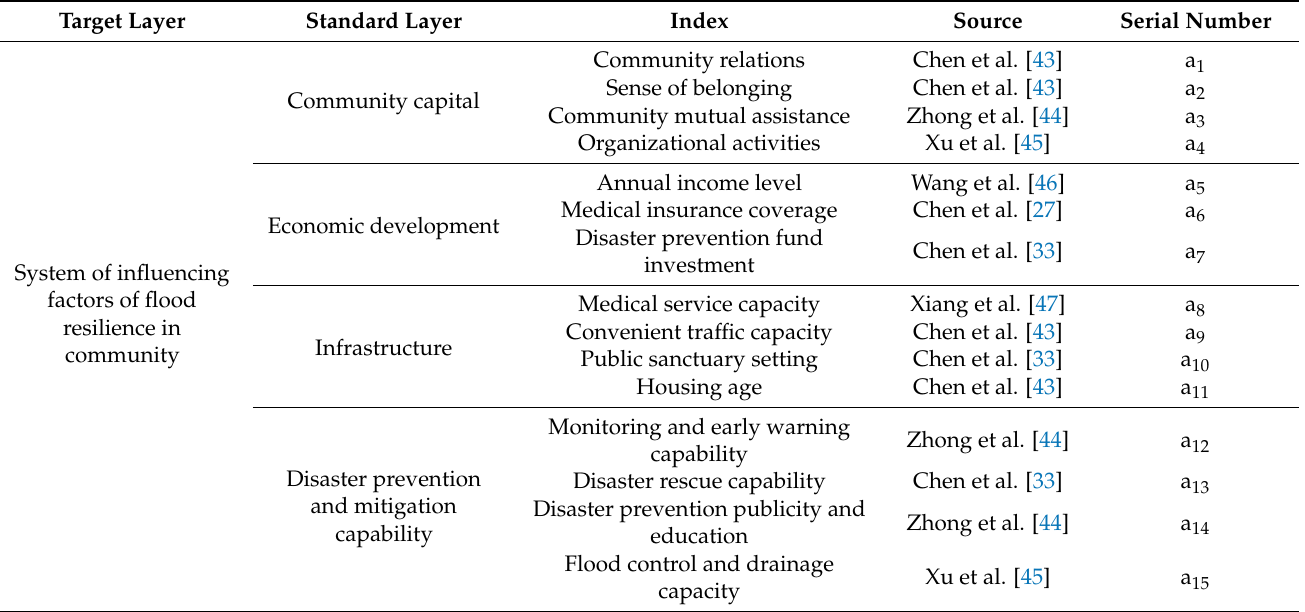
Table 1. System of influencing factors of community flood